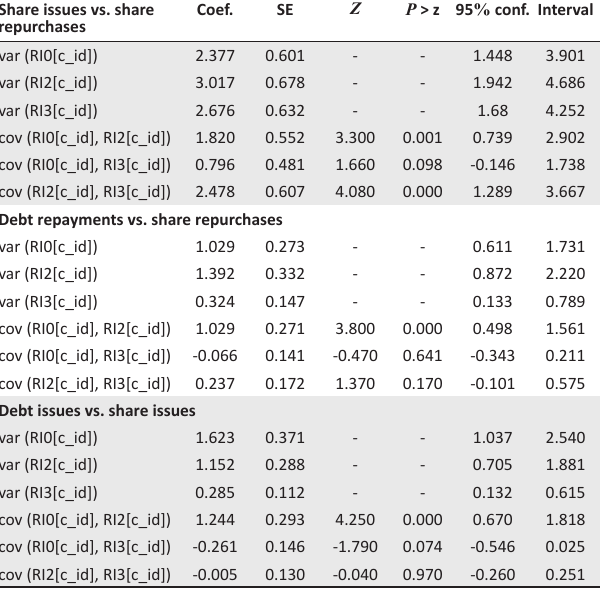
TABLE 1-A1: Summary of statistics for fixed-effect multinomial logistic regression done using generalised structural equation model. Share issues vs. share repurchases